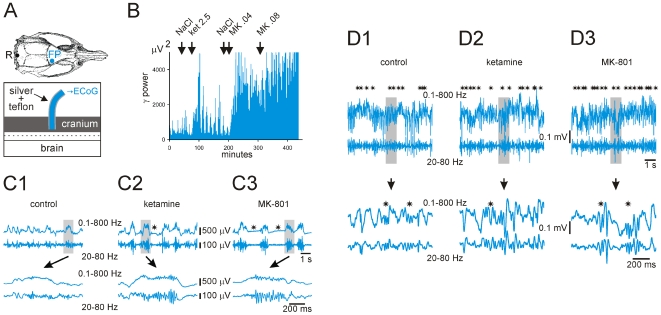
Ketamine or MK-801 increases both the power and the duration of ongoing ECoG γ oscillations under deep anesthesia.(A): Experimental design of the differential monopolar ECoG recording of the frontoparietal (FP) cortex relative to the reference (R) electrode, which is set to ground. The section of the silver wires (insulated with teflon) is put into the cranium (no contact with the meninges), whose contact is made easier with conductive paste. (B): Changes in γ power during a typical 8-hour experiment under urethane-anesthesia, during which the vehicle (NaCl, 0.9%, 1 ml/kg), ketamine (ket, 2.5 mg/kg) and MK-801 (MK, 0.04 and 0.08 mg/kg) were subcutaneously (sc) injected successively at different time (arrows). Note that this chart shows all the power values (resolution: 1.6 sec) of γ oscillations, occurring during and in between the slow waves. (C1–C3, top row): 8-s episode of the frontoparietal ECoG under urethane-anesthesia and three successive conditions (after injection of vehicle [NaCl, 0.9%], ketamine [7 min after injection of 2.5 mg/kg, sc] and MK-801 [18 min after injection of 0.08 mg/kg, sc]). (C1–C3, bottom row): the corresponding 1-s episodes (indicated by the grey back) showing the positive slow waves. The ECoG was recorded with two bandpasses (0.1–800 Hz and 20–80 Hz). The asterisks in (C2) and (C3) indicate periods of “electrical silence”. (D1–D3): A typical experiment done under deep pentobarbital anesthesia. Top row: 8-s episode of the frontoparietal ECoG under three conditions (after subcutaneous injection of vehicle [control], ketamine [20 min after injection of 5 mg/kg, sc] and MK-801 [40 min after 0.08 mg/kg, sc]). Bottom row: the corresponding 1-s episodes (indicated by the grey back). The ECoG was recorded with two bandpasses (0.1–800 Hz and 20–80 Hz). Asterisks indicate γ bursts.